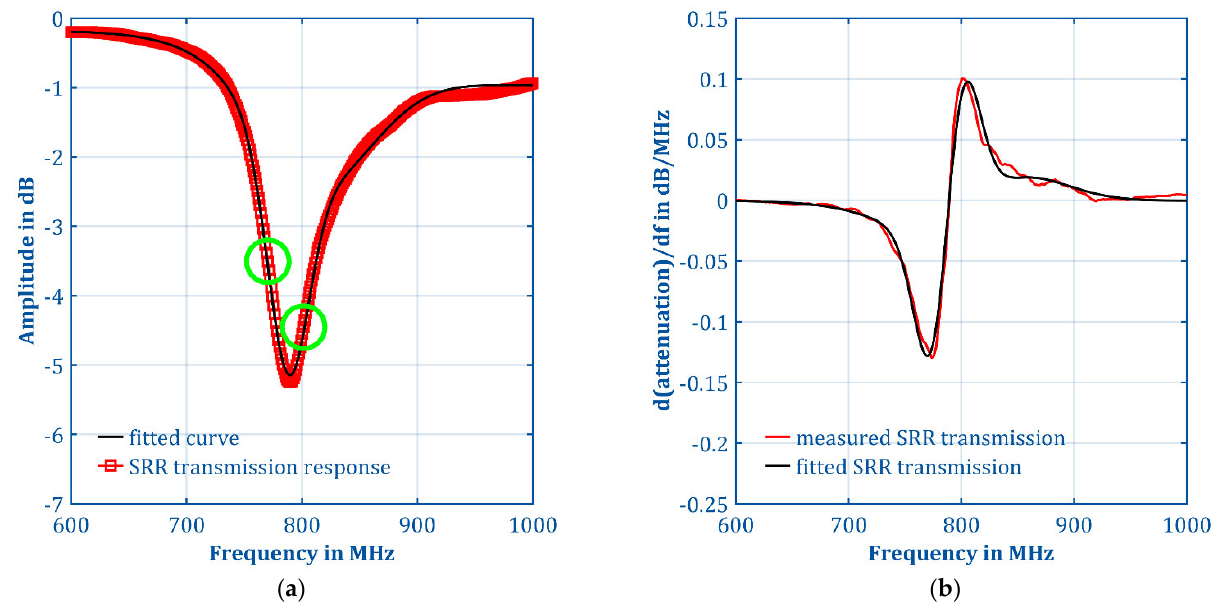
Figure 8. ( a ) Measured (red squares) and fitted (black curve) transmission response of the CaSRR loaded with 25% ultrapure water and 75% acetonitrile used as an eluent in the HPLC experiments. The resonance frequency was 789.5 MHz, and the maximum attenuation was − 5.246 dB. The green circles marked the optimum excitation frequencies below and above the resonance frequency for the highest sensitivity regarding the detection of resonance frequency shifts. ( b ) Differentiation of the measured and fitted CaSRR transmission response of the CaSRR loaded with eluent. The inflection points for the measured curve are at 774.5 MHz and at 801.5 MHz. For the fitted curve, the inflection point frequencies differ slightly, and are 770.264 MHz and 806.378 MHz, respectively.